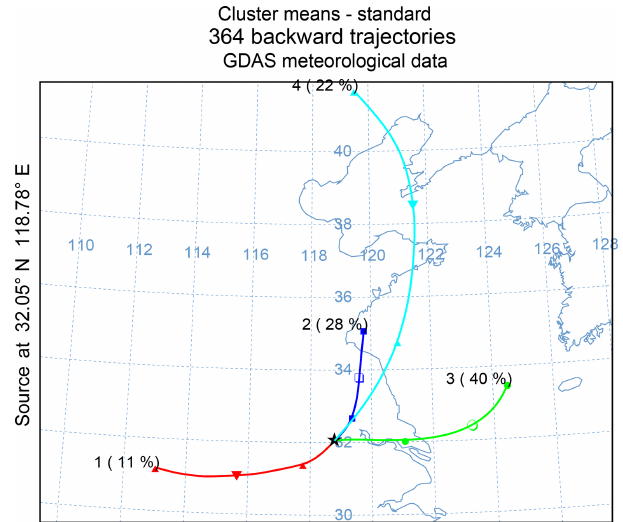
Figure 11. Clusters of 96h back trajectories arriving at the Gulou site at 100m in the fall of